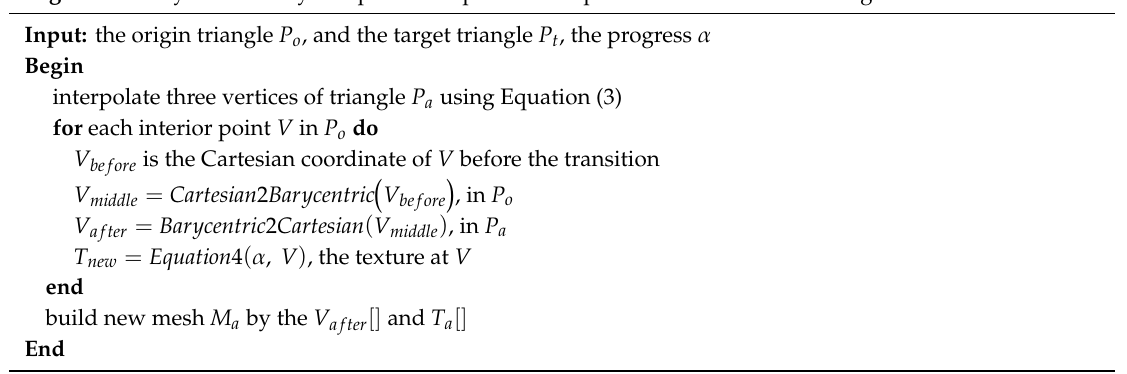
Algorithm 1. Synchronously Morph the Shape and Interpolate the Texture of a Triangle